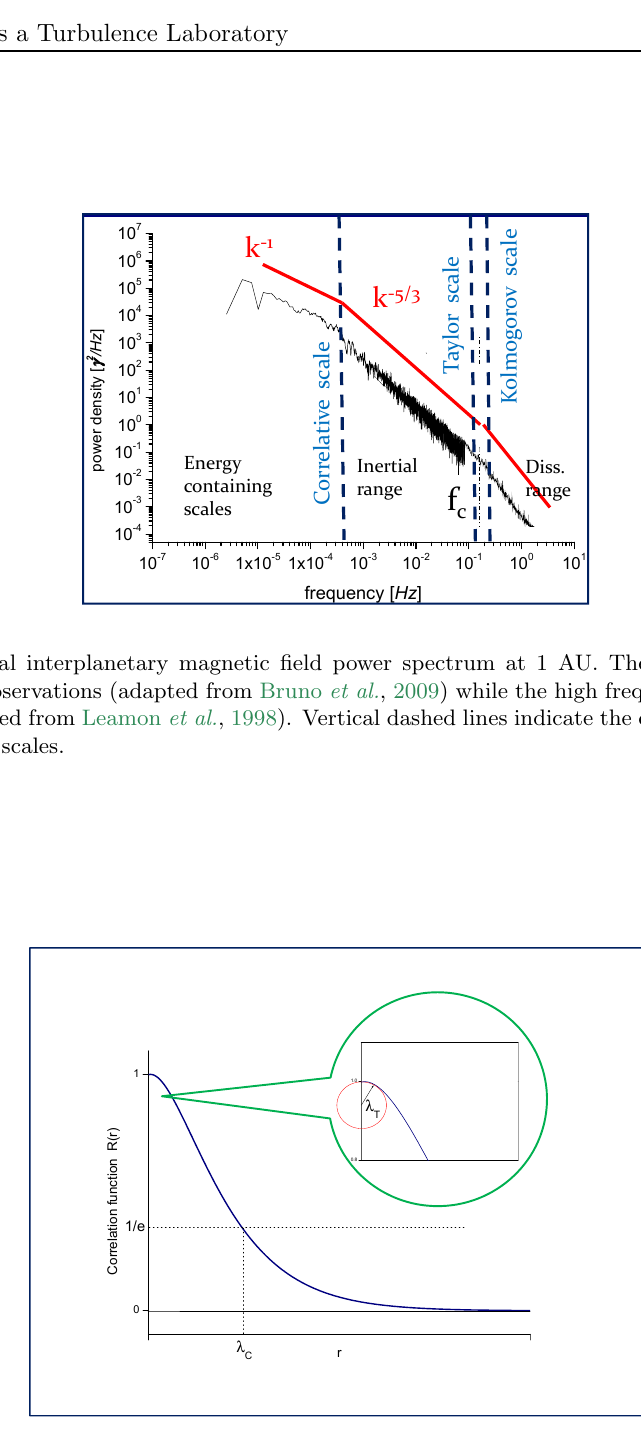
Figure 26: Typical two-point correlation function. The Taylor scale 𝜆 𝑇 and the correlation length 𝜆 𝐶 are the radius of curvature of the Correlation function at the origin (see inset graph) and the scale at which turbulent fluctuation are no longer correlated,